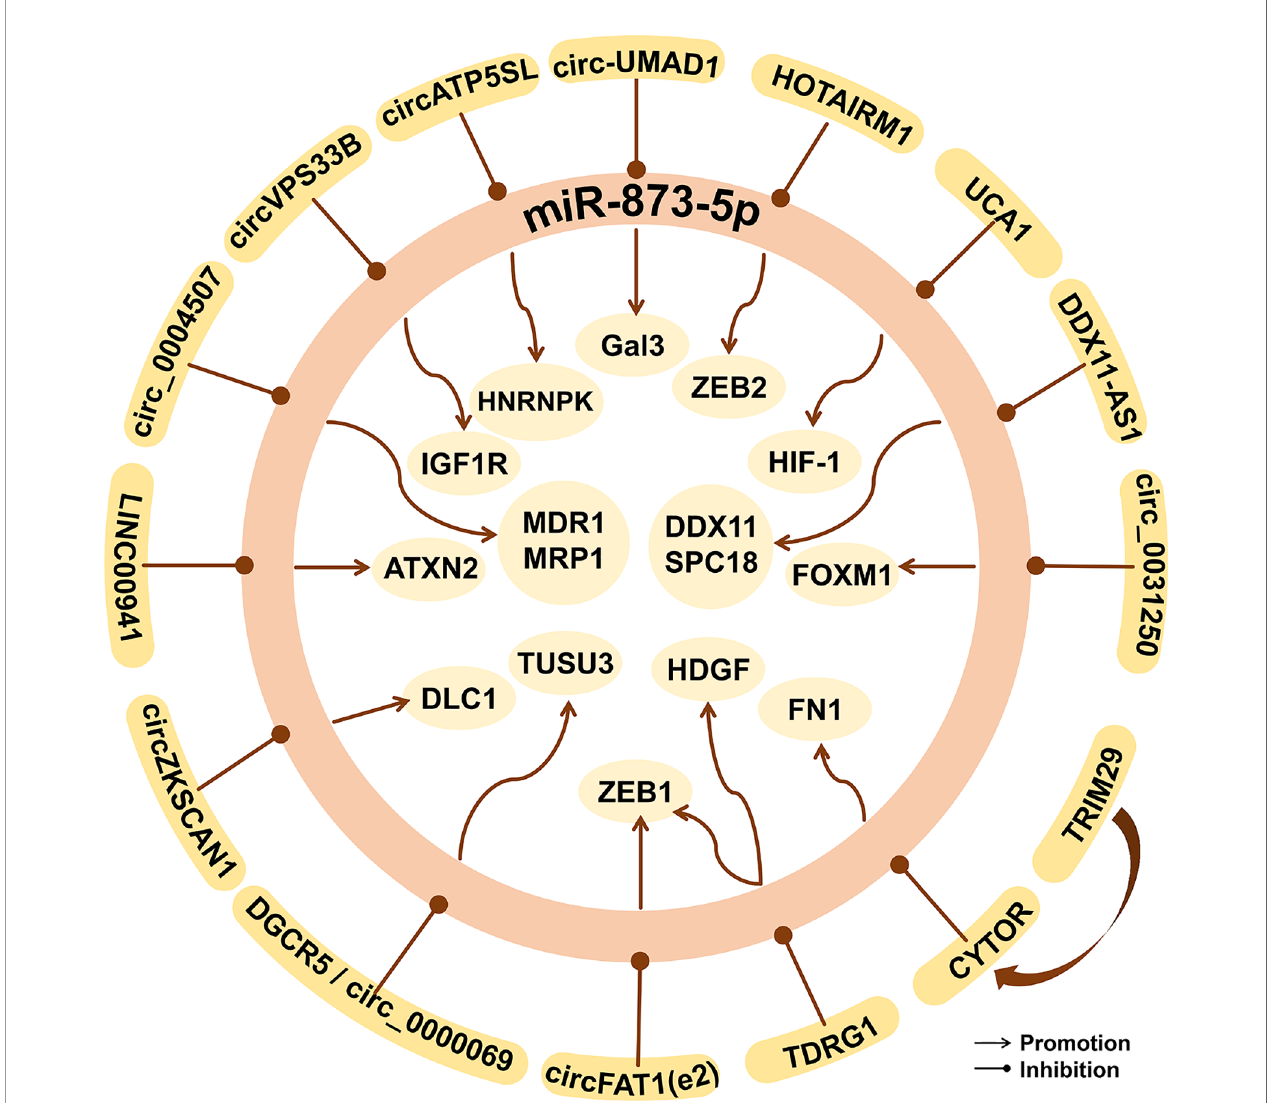
FIGURE 7 | The epigenetic factors of miR-873-5p in human cancer. miR-873-5p can be targeted and regulated by lncRNAs, circRNAs, and other proteins, thus affecting downstream gene expression and playing an important role in cancer.